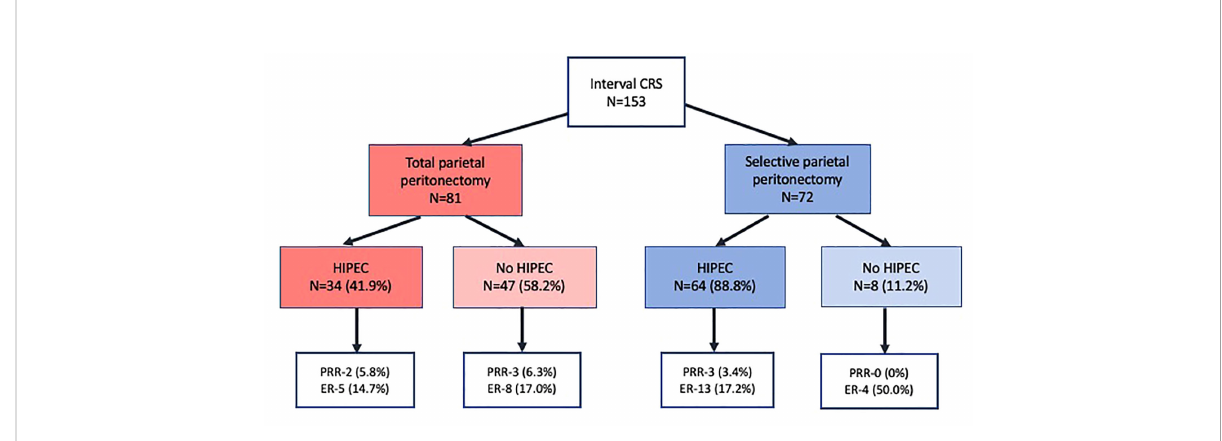
FIGURE 1 Platinum resistant recurrence and early recurrence in 153 patients undergoing interval cytoreductive